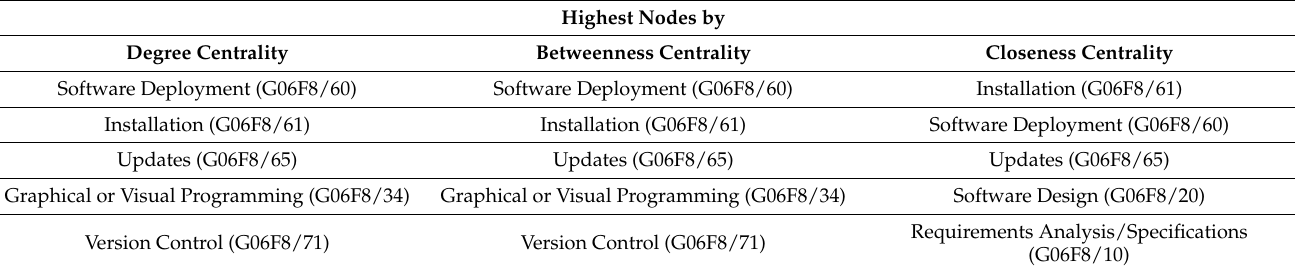
Table 10. Network analysis of CCN. Highest Nodes